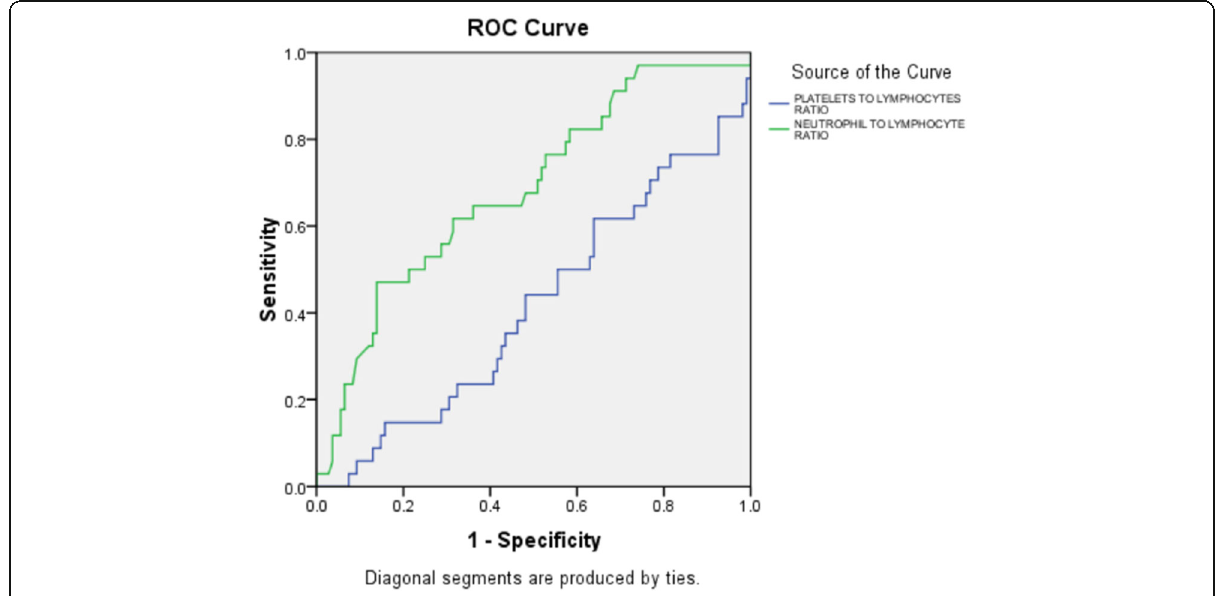
Fig. 3 ROC curve to detect severe sepsis using the platelet-to-lymphocyte ratio and neutrophil-to-lymphocyte